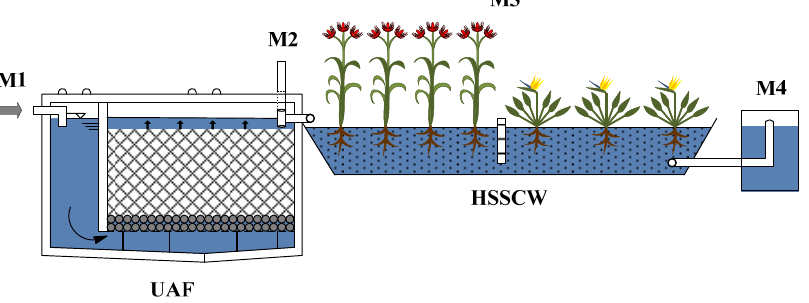
Figure 2. Sampling points in the wastewater treatment system. M1-influent; M2-outlet UAF/inlet HSSCW; M3-middle part of HSSCW; and